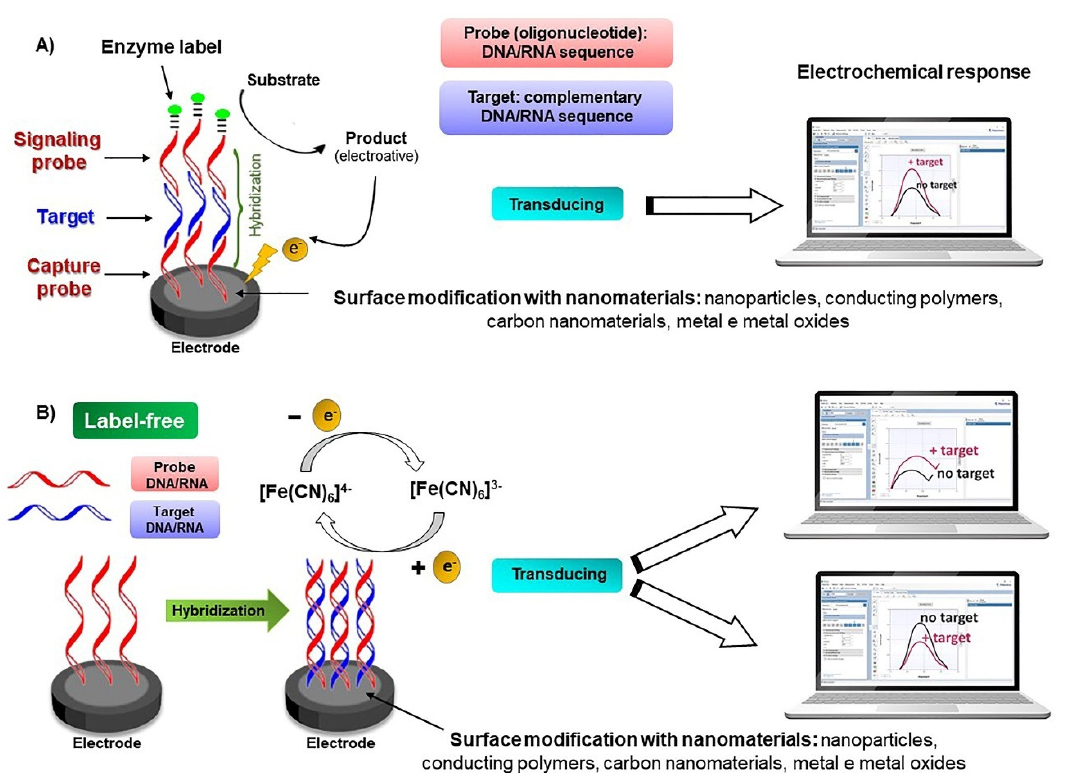
Scheme 2. General representation of the main components and detection principles of classical ( A ) and label-free ( B ) electrochemical nucleic acid